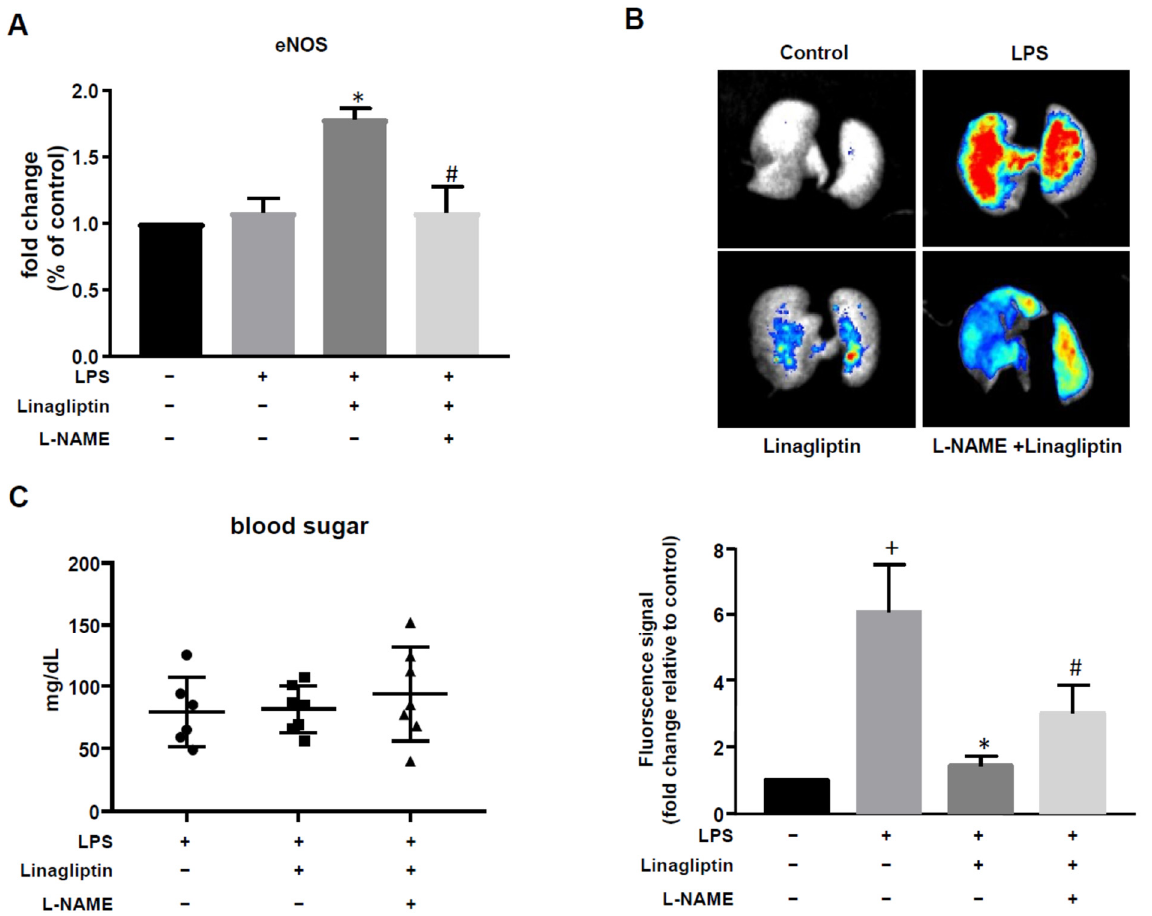
Figure 4. Linagliptin increased eNOS expression and suppressed microvascular thrombosis. L- NAME was added into feeding water for 2 weeks before linagliptin treatment. Mice were fed linagliptin 2 days before LPS injection. ( A ) The fold change in eNOS expression was measured by qPCR. ( B ) Microvascular thrombosis was detected by fluorescence imaging using fluorescent microbeads. ( C ) Blood sugar levels of LPS-injected mice with or without L-NAME or linagliptin treatment. n = 7 in each group. + p ≤ 0.05 compared to control. * p ≤ 0.05 compared to LPS-treated group. # p ≤ 0.05 compared to LPS plus linagliptin-treated group.